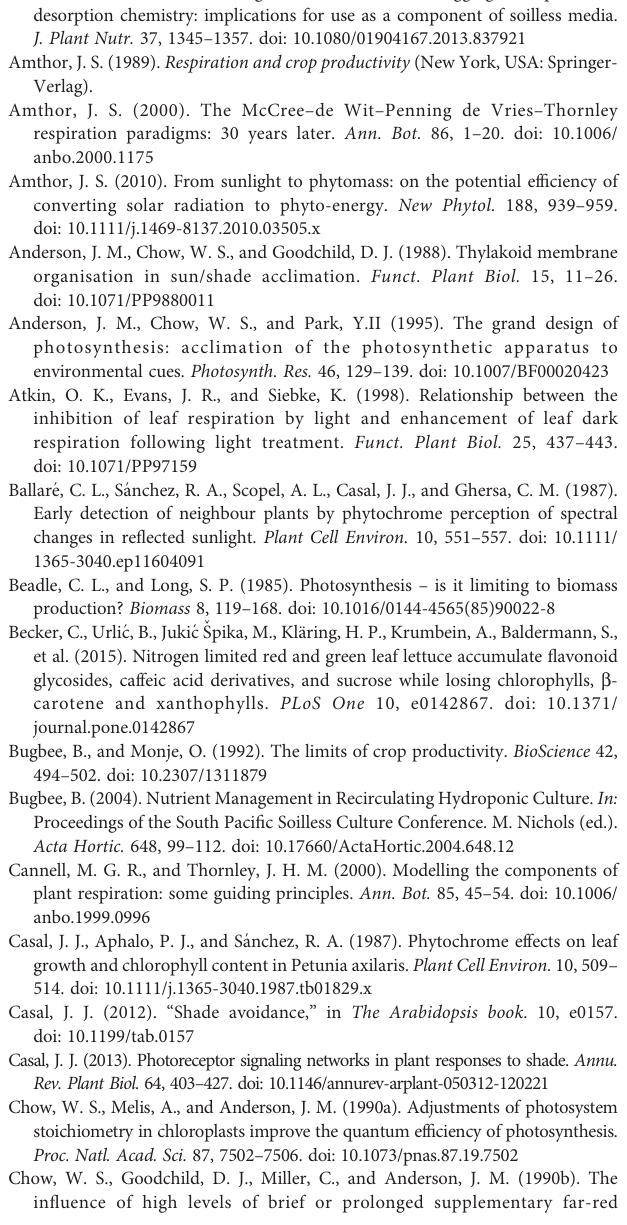
SUPPLEMENTARY FIGURE 1 | Canopy net photosynthetic rate (P net ; m mol CO2 m − 2 ground area s − 1 ) of lettuce under red/blue (RB) and white, with or without far-red substitution. The numbers following each type of light ( e.g. RB 350) indicate photon fl ux